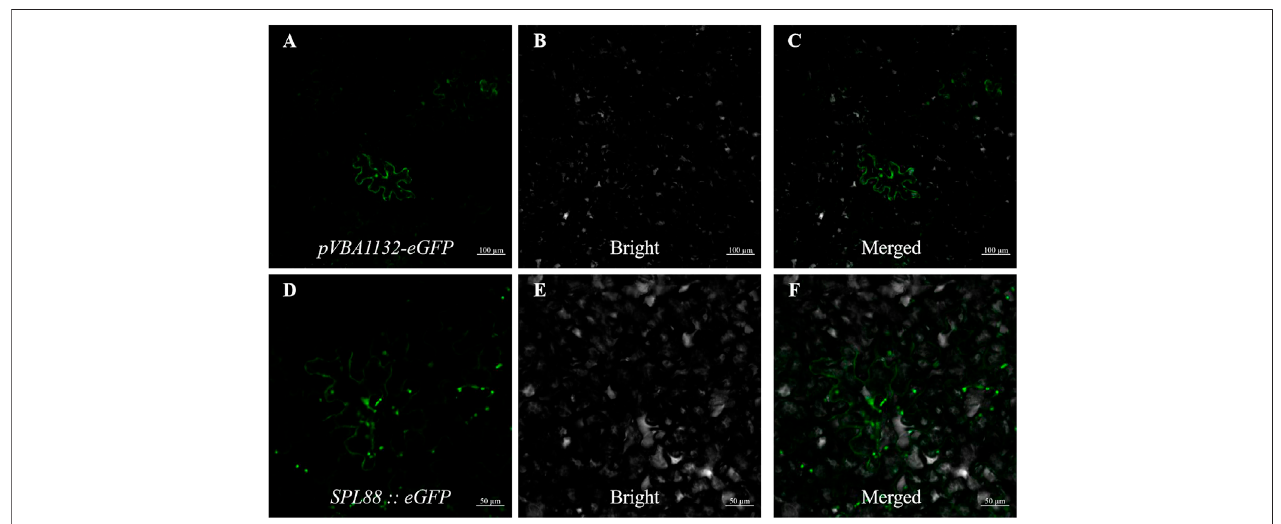
FIGURE8| Subcellularlocalizationof SPL88 ; (A – C) :transientexpressionof pVBA1132-eGFP intobacco,Bar:100 μ m; (D – F) :transientexpressionof pVBA1132: SPL88::eGFP in tobacco, Bar: 50 μ